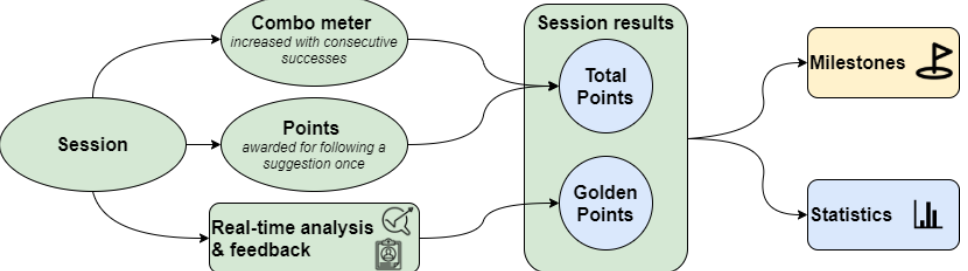
Figure 5. Gamification approach based on session awarded points. Users can monitor their perfor- mance on the dashboard, examine key statistics and major milestones that reflect their